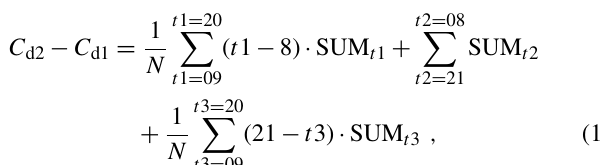
Figure 6. The profile evolution of averaged (a) ozone concentration and (b–e) CHEM, VMIX, CONV, and ADV of region D0 from 08:00, 5 July, to 20:00, 10 July. The black lines denote the planetary boundary layer height